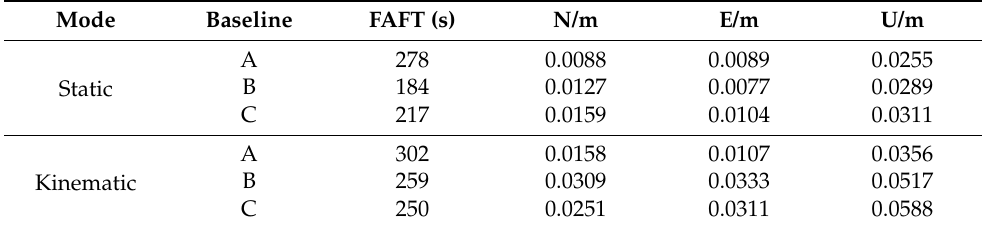
Table 7. The RMS statistical results of Baseline A, Baseline B and Baseline